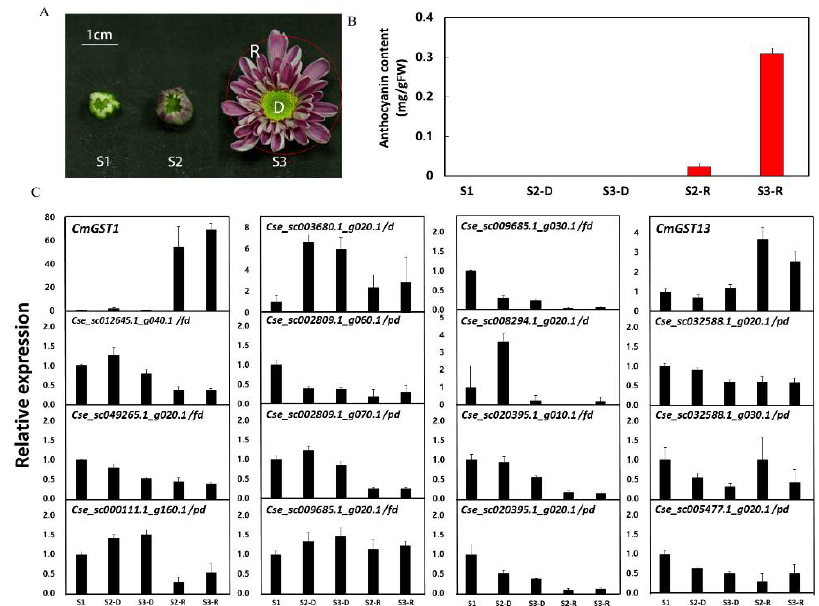
Figure 2. Expression patterns of CmGSTs from Phi subclade in disc and ray flowers in developmental stage of ‘Monalisa Pink’. ( A ) Phenotype of ‘Monalisa Pink’ at S1, S2-D, S3-D, S2-R, S3-R. ( B ) Anthocyanin contents of disc and ray flowers of different developmental stages. ( C ) Relative expression of disc and ray flowers. Data were means ( ± SE) from three independent biological replicates.